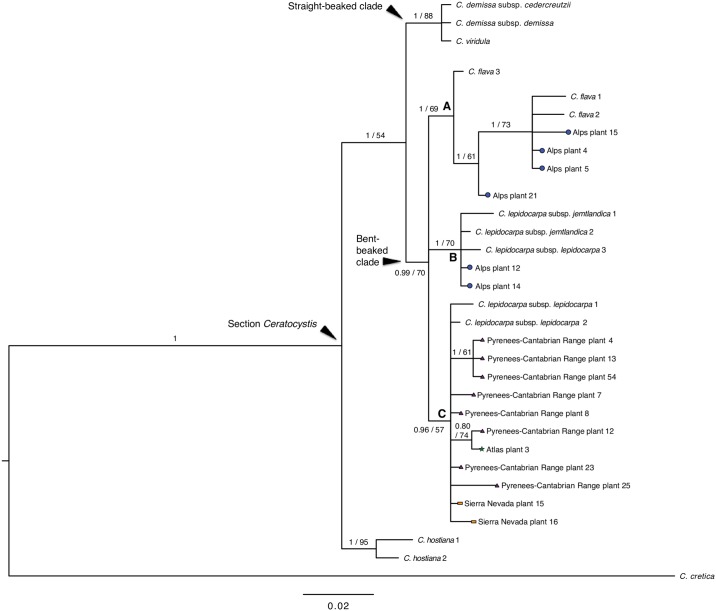
Fifty-percent majority rule consensus tree obtained from the Bayesian phylogenetic analysis of Carex sect.Ceratocytis based on the combined matrix of ITS and rps16-5’trnK sequences with coded indels. Bayesian posterior probabilities equal or greater than 0.8 are given next to the branches before the slash; bootstrap supports from the ML analysis are given after the slash when greater than 50. Straight-beaked and bent-beaked clades are indicated. Well-supported clades within the bent-beaked clade are named as follows: (A) C. flava lineage, (B) C. lepidocarpa B lineage, and (C) C. lepidocarpa C lineage. Sample numeration follows S1 Appendix. Shapes at the terminals indicate the dwarf mountain morphotypes according to Figs 1 and 3.